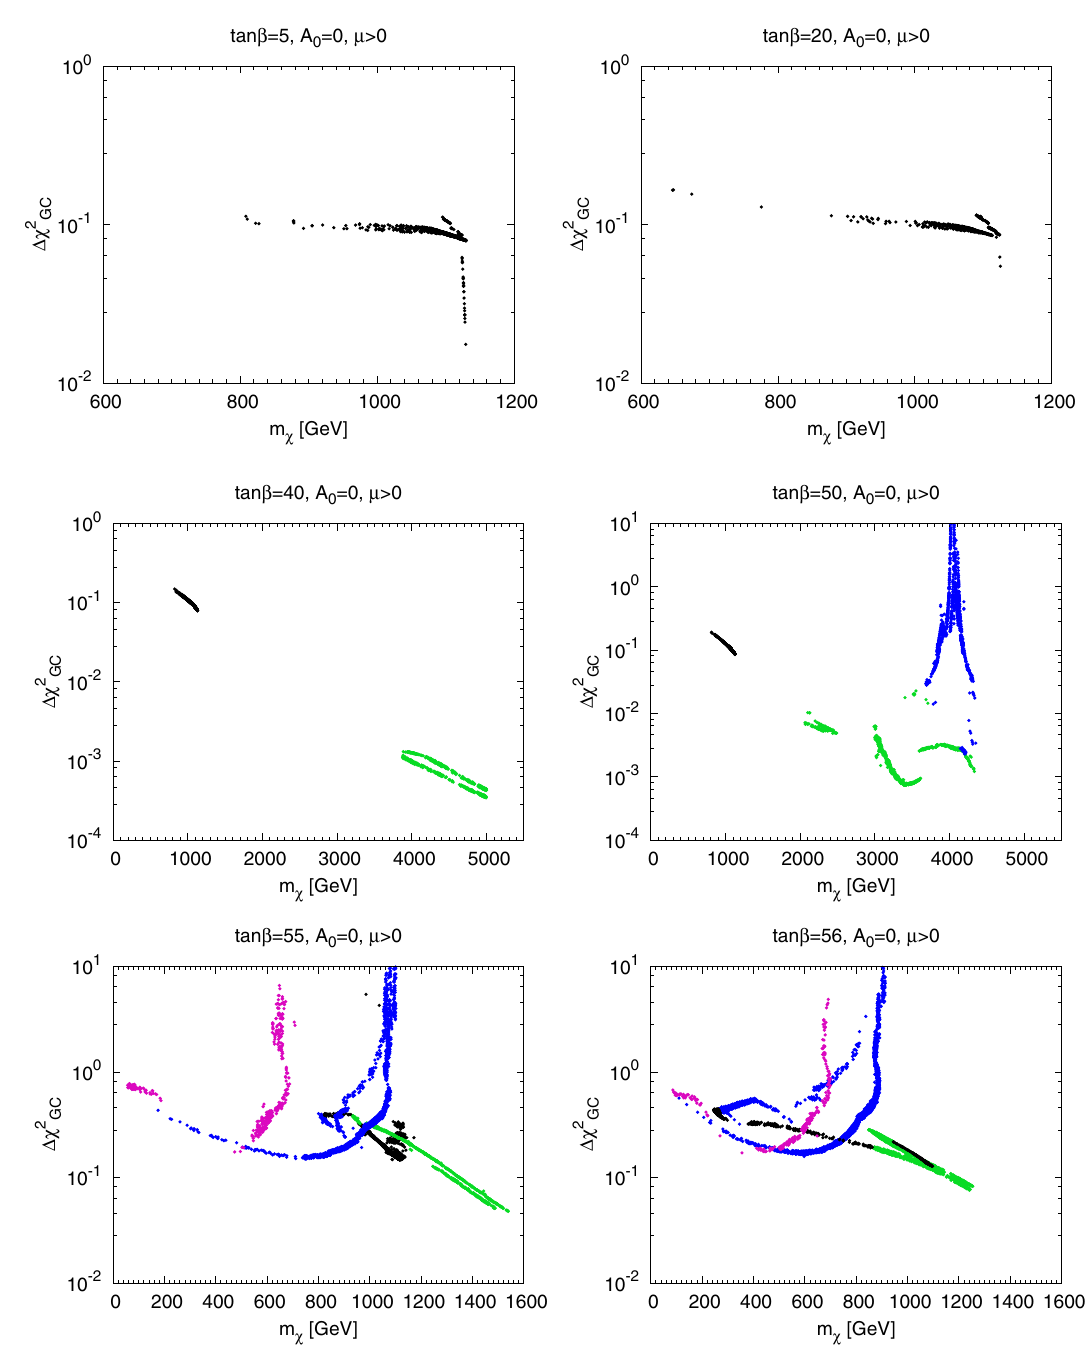
Fig. 12 Contributions to the global χ 2 likelihood function from a comparison of the H.E.S.S. upper limit on the flux of γ -rays from the Galactic Centre with calculations for points along the dark matter strips for tan β = 5 , 20 , 40 , 50 , 55 and 56 with A 0 = 0 and μ >